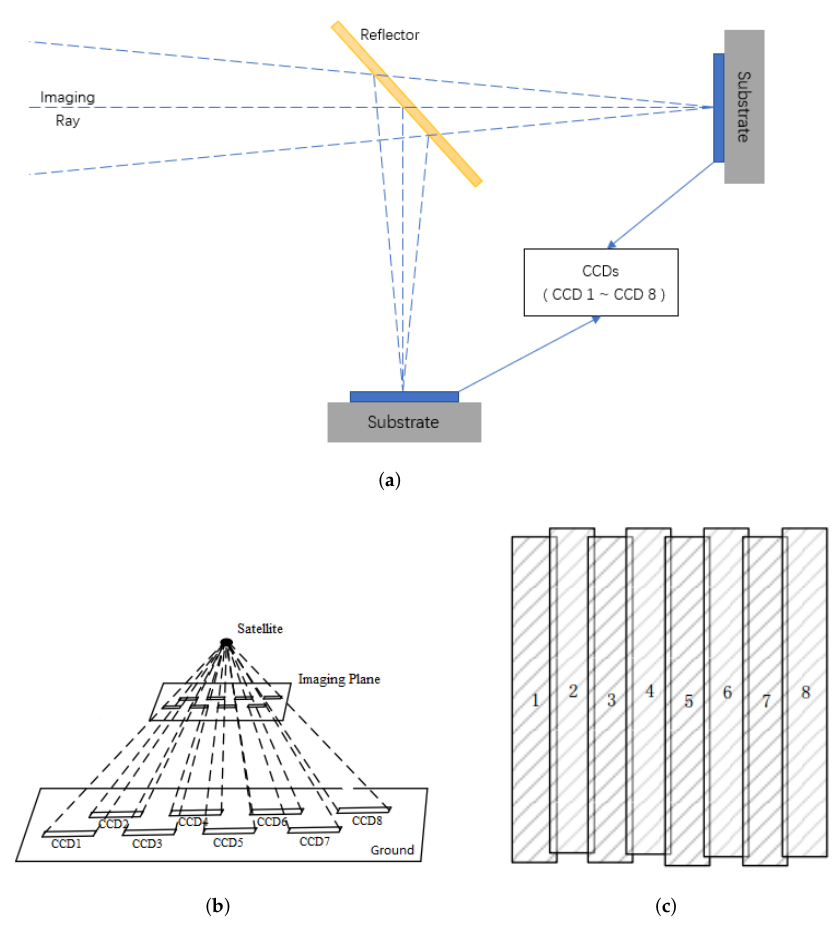
Figure 4. Illustration of imaging principles of multiple CCD stitching [28]: ( a ) imaging principle of multiple CCD in focal plane, ( b ) imaging Mode, and ( c )